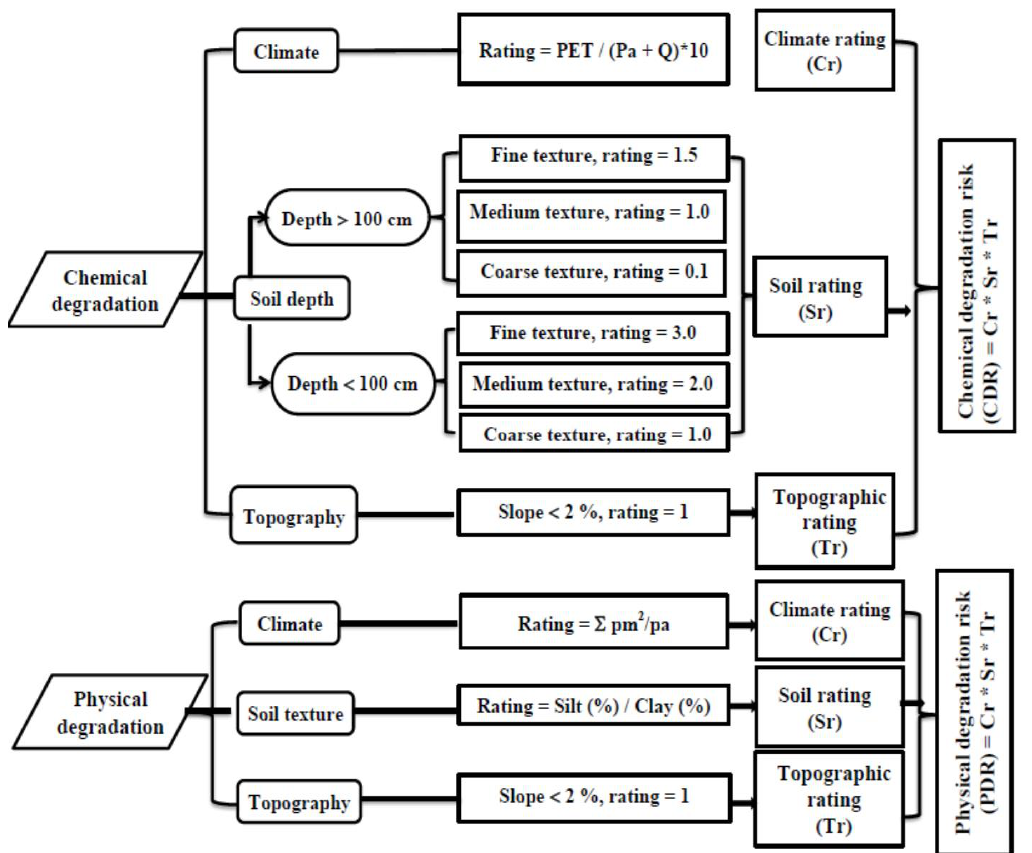
Figure 1. Flowchart showing the potential evapotranspiration (PET, mm per year), annual precipita- tion (PA, mm), monthly precipitation (PM, mm), and quantity of irrigation water (Q) for the risk of soil degradation (mm year − 1 ), in accordance with